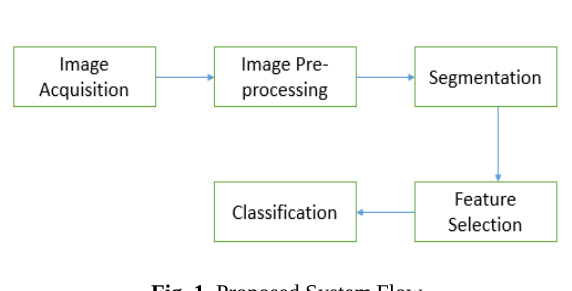
Table 1 . Specifications for Datasets Fig. 1. Proposed System